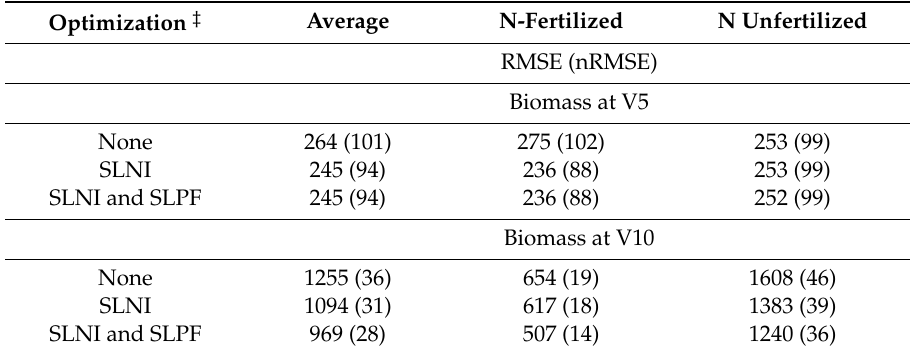
Table 4. Root mean square error (RMSE; kg ha − 1 ) and normalized RMSE (nRMSE; %) between measured and simulated maize biomass in nitrogen (N)-fertilized and unfertilized treatments at five (V5) and ten leaf collar (V10) stages, with and without spatial